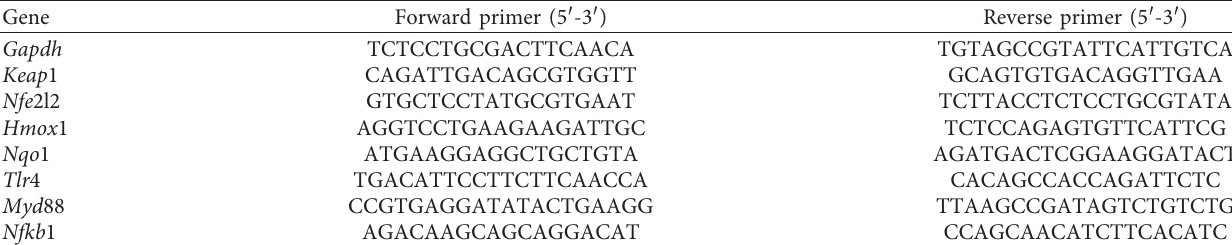
Table 1: Primer sequences of genes used for